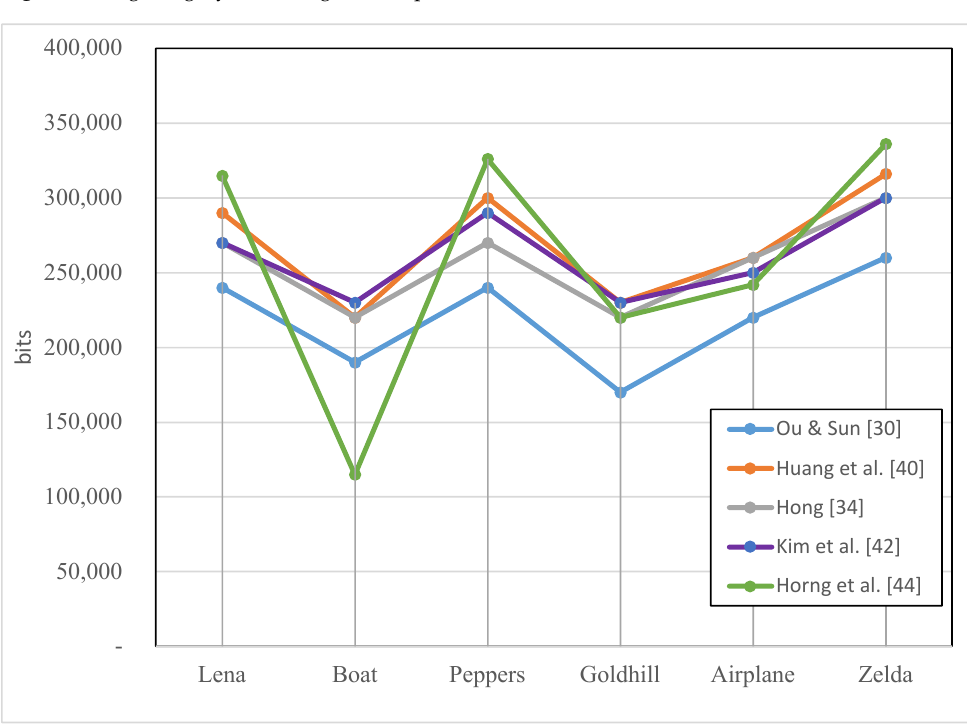
Figure 8. Comparisons of EC performance among existing DH